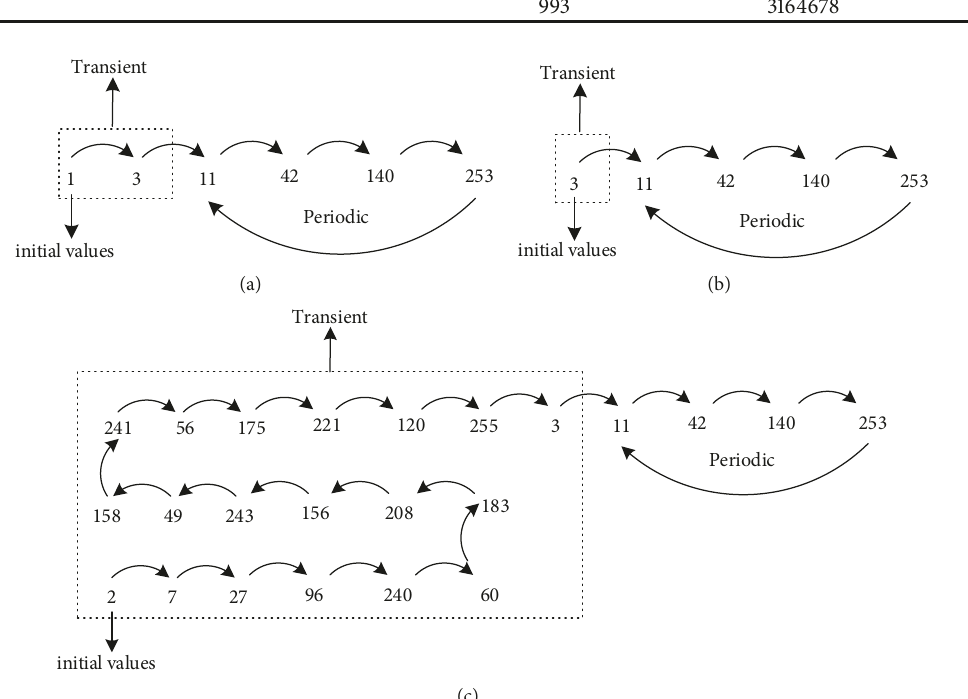
Figure 2: The illustration of iterations of the Logistic mapping with different initial values. (a) 𝑧 1 = 1 ; (b) 𝑧 1 = 3 ; (c) 𝑧 1 = 2